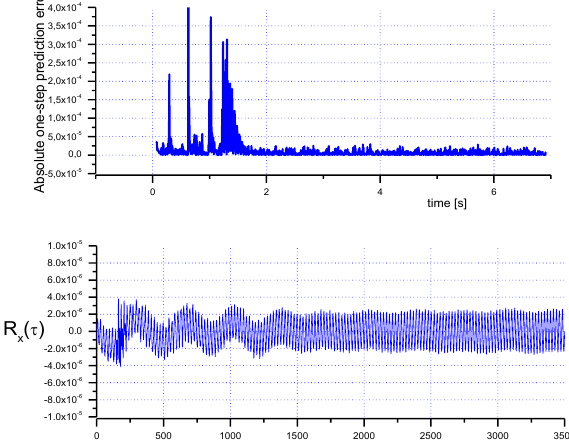
Fig. 7 . The courses of absolute error  and autocorrelation function of remainders R x (  ) for n =2 model